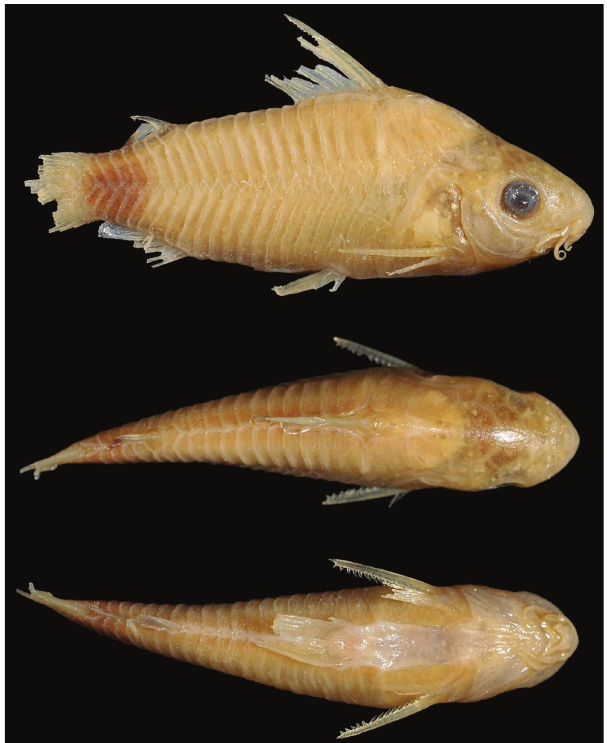
Fig. 1. Holotype of Corydoras guapore , ZMB 21406, 33.3 mm SL, Brazil, Rondônia State, main stream of the upper rio Guaporé. Lateral, dorsal and ventral views. Photo by Mark Allen, All Catfish Species Inventory (NSF